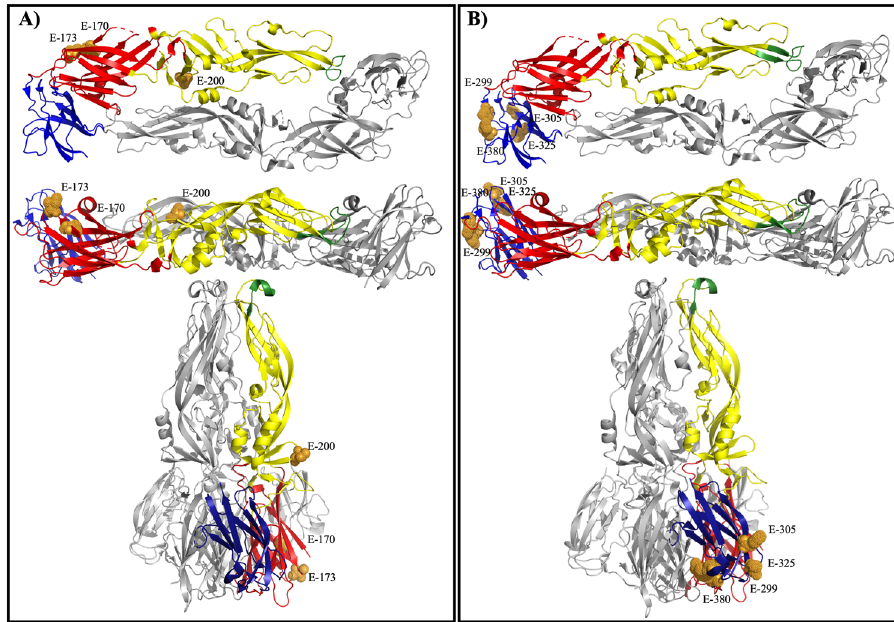
Fig. 3 WT-speci fi c epitope mapped to YFV EDI/EDII of the E protein and vaccine-speci fi c epitope mapped to YFV EDIII. Residues important to the mAb 117 epitope in both Asibi and 17D backbones were mapped to the prefusion E protein structure and displayed from the top and side view and post-fusion structure ( A ). Residues important to the mAb 411 epitope in both Asibi and 17D backbones were mapped to the prefusion E protein structure and displayed from the top and side view as well as the post-fusion structure ( B